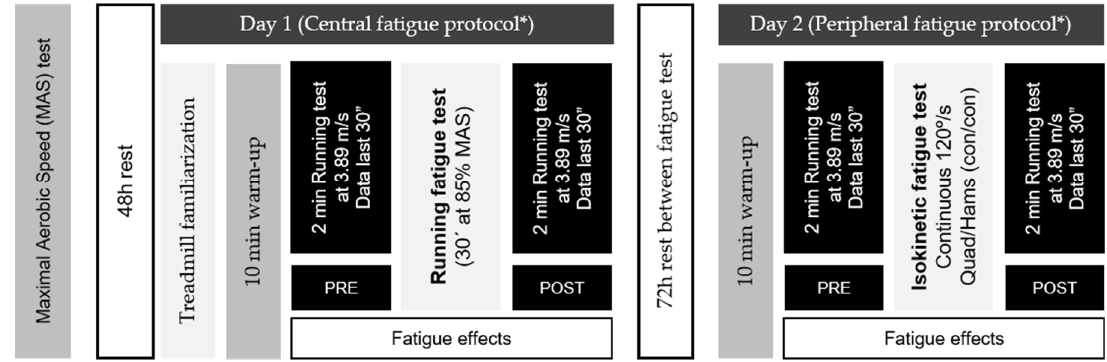
Figure 1. Schematic representation of the study protocol. * The order of fatigue protocol was randomized.